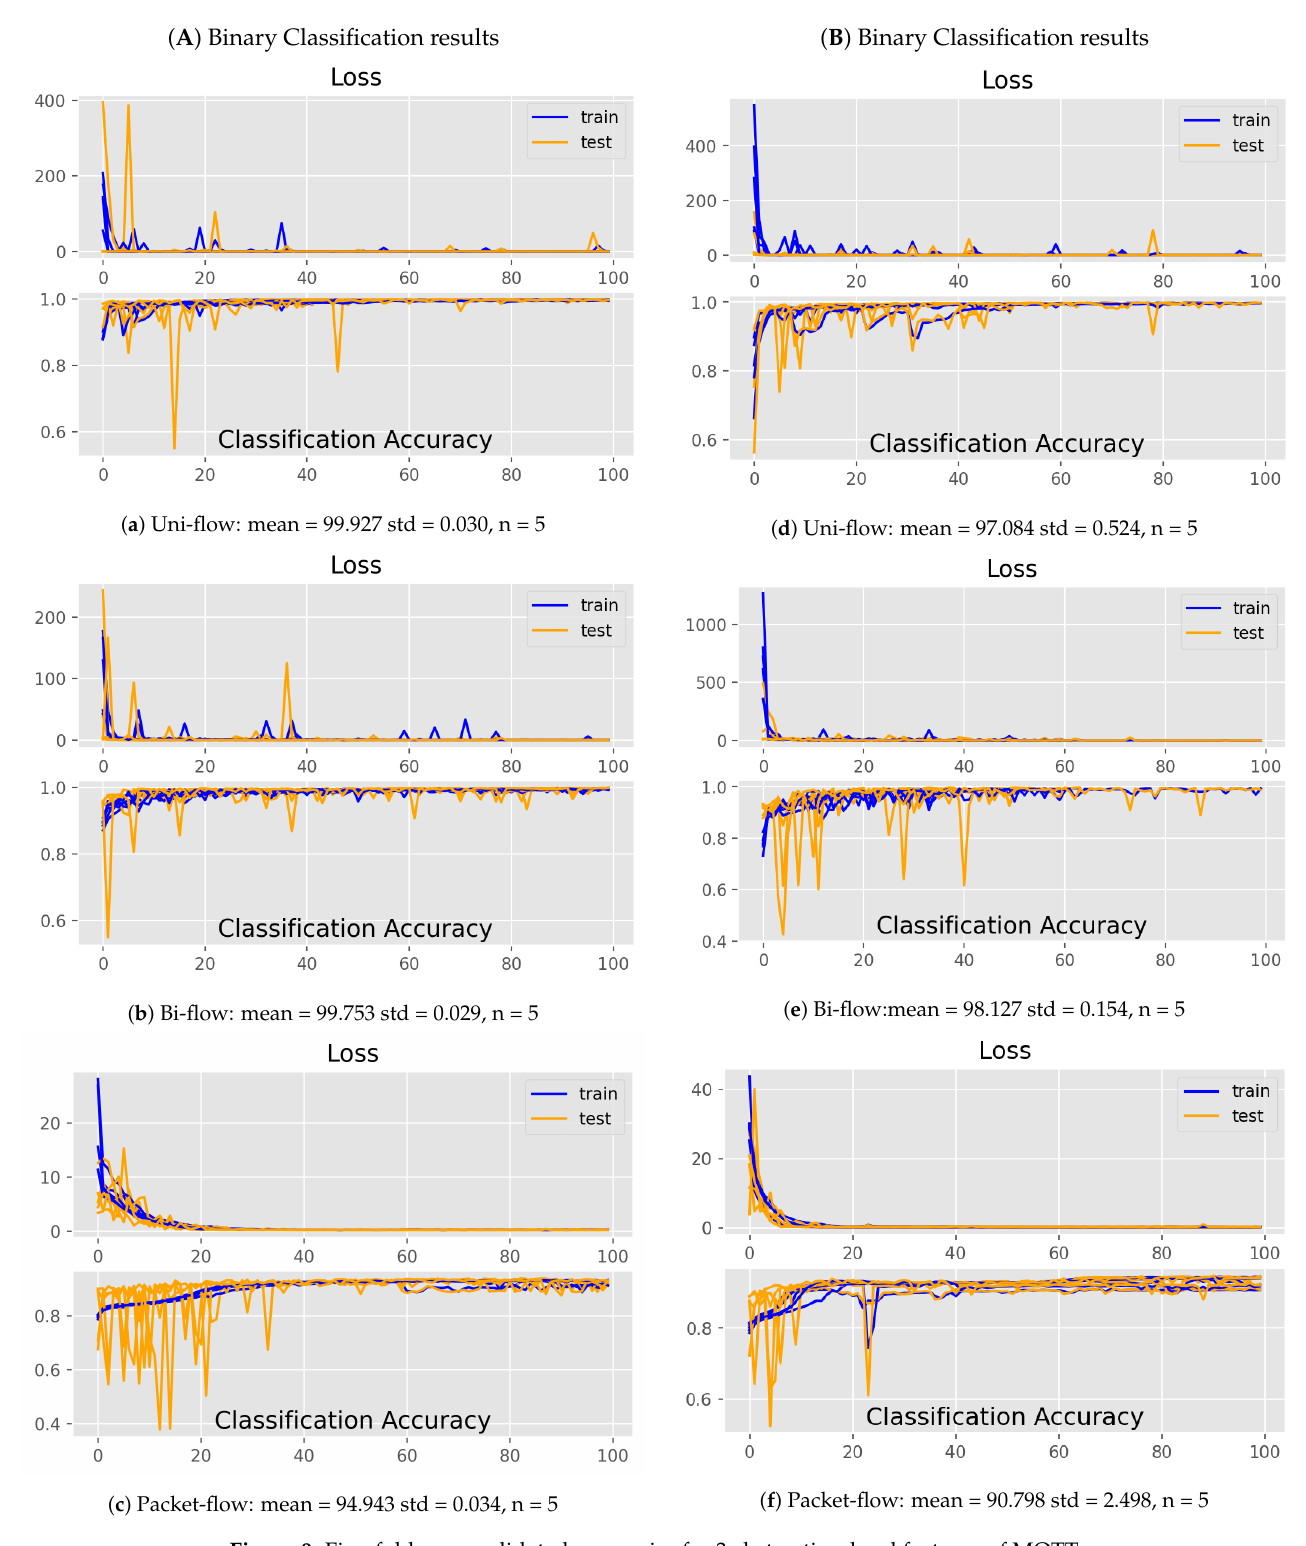
Figure 9. Five-fold cross validated accuracies for 3 abstraction-level features of